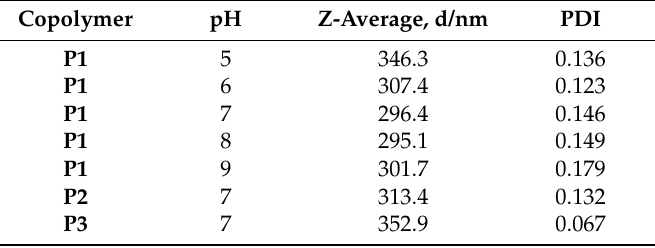
Table 4. Self-assembled particle size distribution and PDI of micelles at different pH